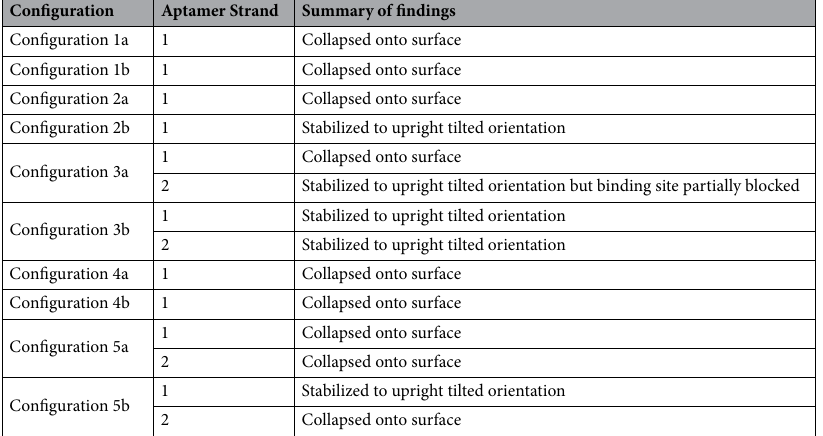
Table 3. Aptamer orientation—summary of findings.